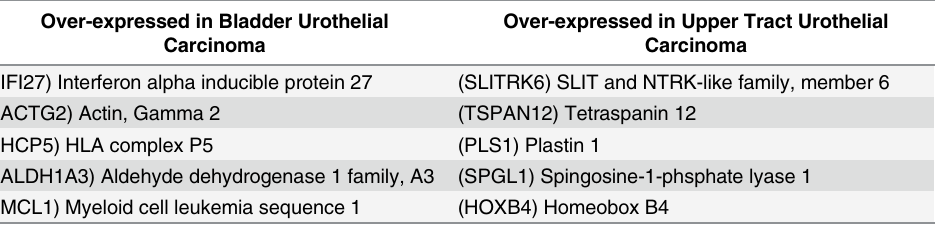
Table 2. Top Over-Expressed Genes in Bladder and Upper Tract Urothelial